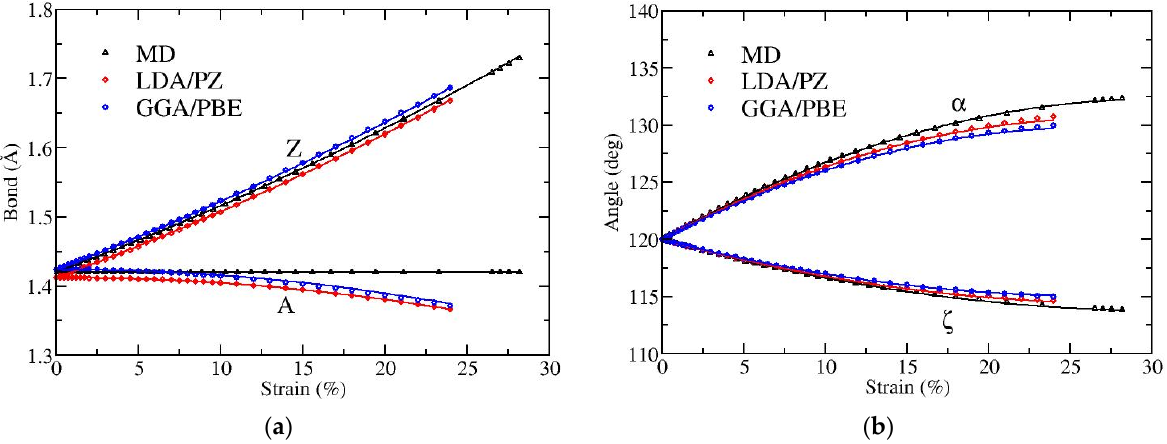
Figure 3. Strain dependence of ( a ) bond lengths and ( b ) bond angles, for uniaxial strain along the zigzag direction of graphene. A and Z in ( a ) [α and ζ in ( b )] correspond to the different kinds of bonds [angles], as shown in Figure 1. Black points show results obtained by MD, while red and blue points show data obtained by DFT using LDA and GGA functionals, respectively. Lines represent fits with quadratic polynomials [see Equations (1) and (2)].